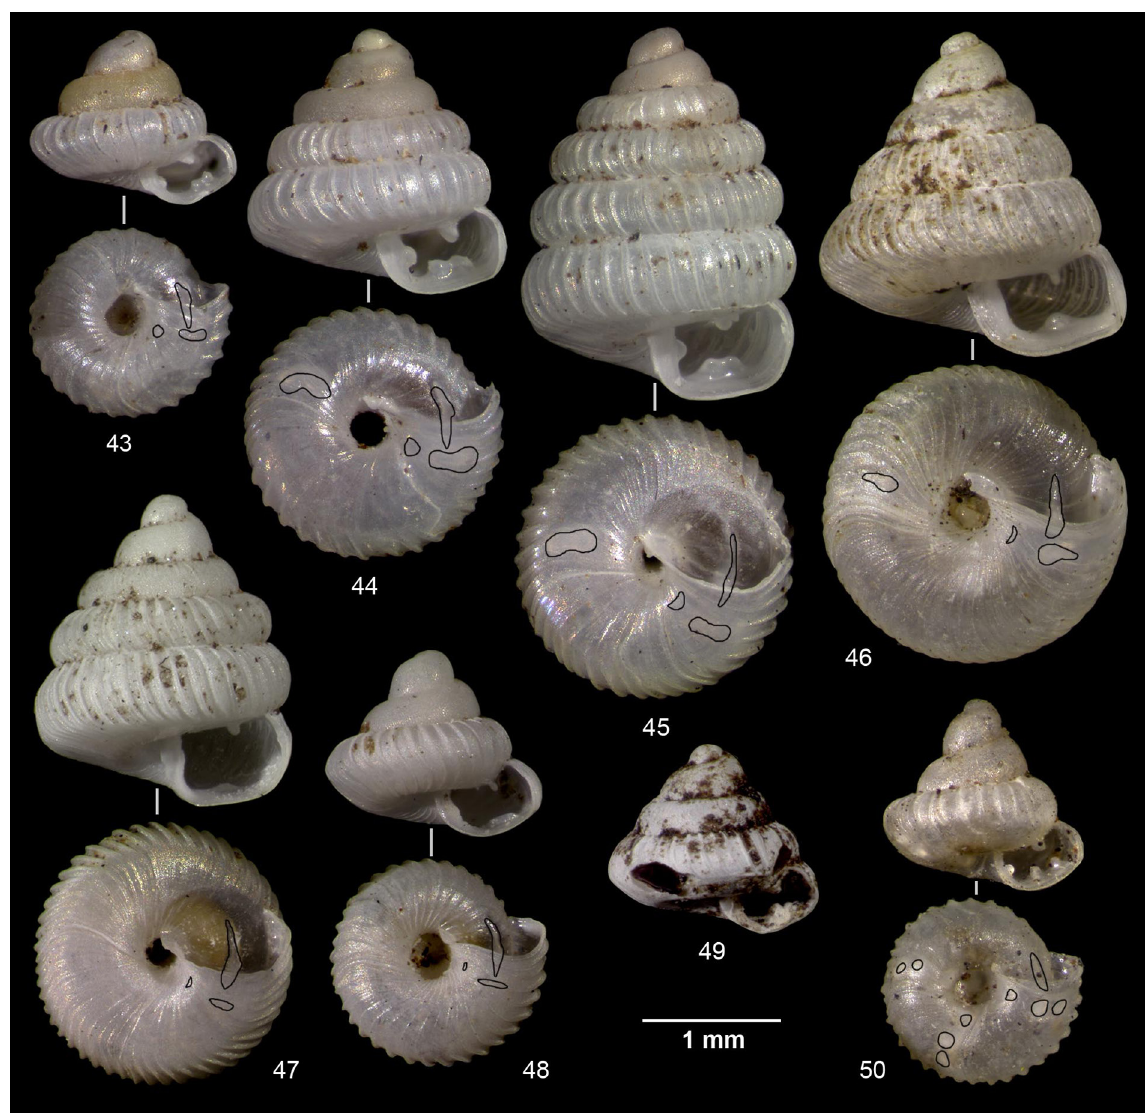
Figs 43-50. Juvenile shells of Dadagulella gen. nov. species, with dentition emphasized in basal view including earlier dentition visible through the shell. 43-45. D. radius radius , Mbudya I. 46. D.